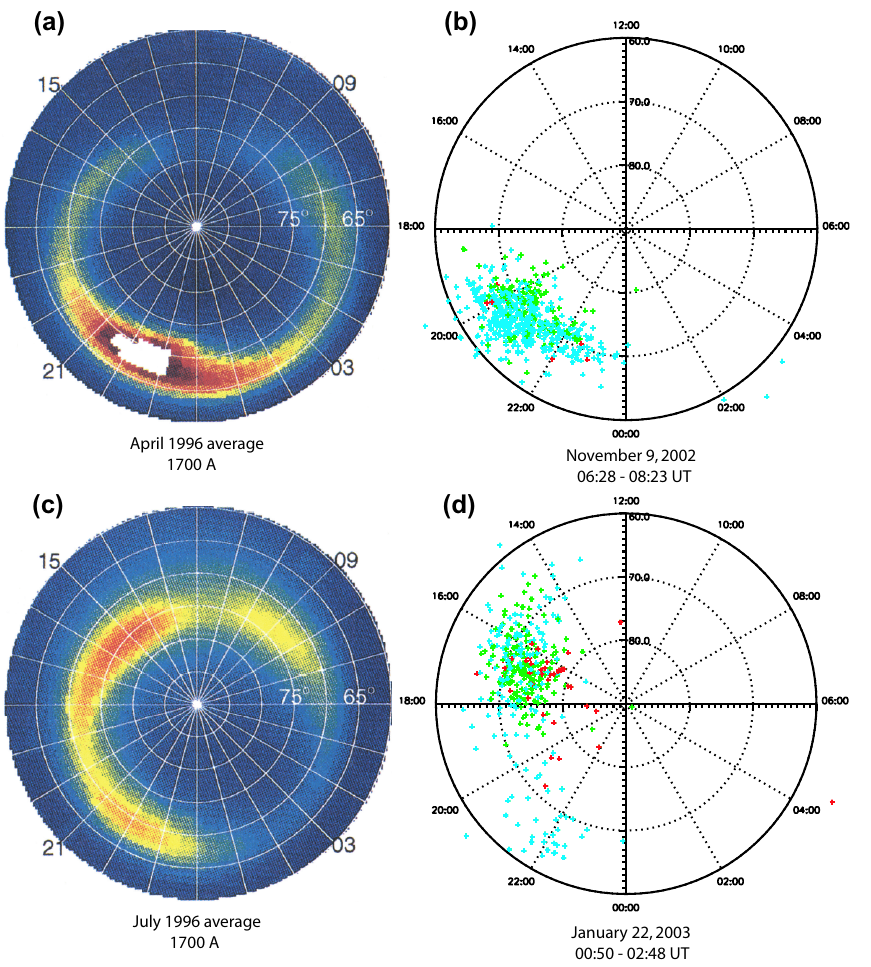
Fig. 8. (a) Monthly average map of UV ( ∼ 1700 ˚A) auroral emission in magnetic coordinates during April 1996 from Polar UVI imagery (Liou et al., 1997). (b) AKR burst emission locations on 9 November 2002 from 06:28–08:23 UT. The AKR locations are projected onto 100km altitude by following magnetic field lines from each burst location. Frequency color coding is the same as in Fig. 3. (c) Same as (a) but for July 1996. (d) Same as (b) but for 22 January 2003 from 00:50–02:48